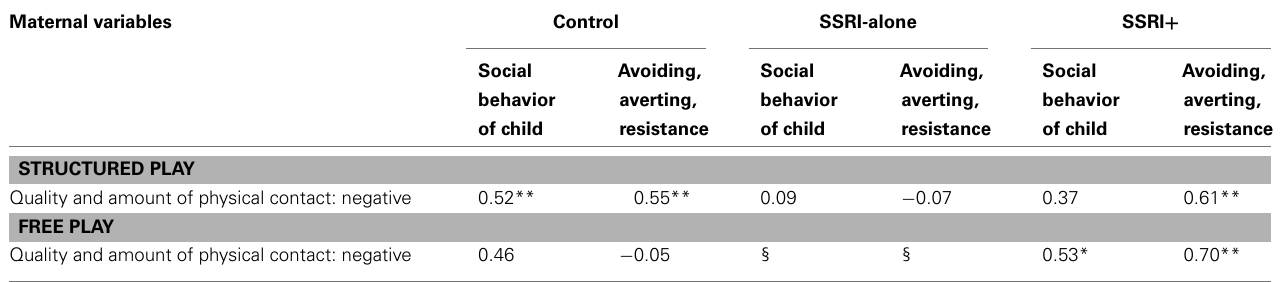
Table 7 | Intercorrelations (Kendall’s tau b) between maternal social variables and infant social variables for the three groups during structured play and free play at